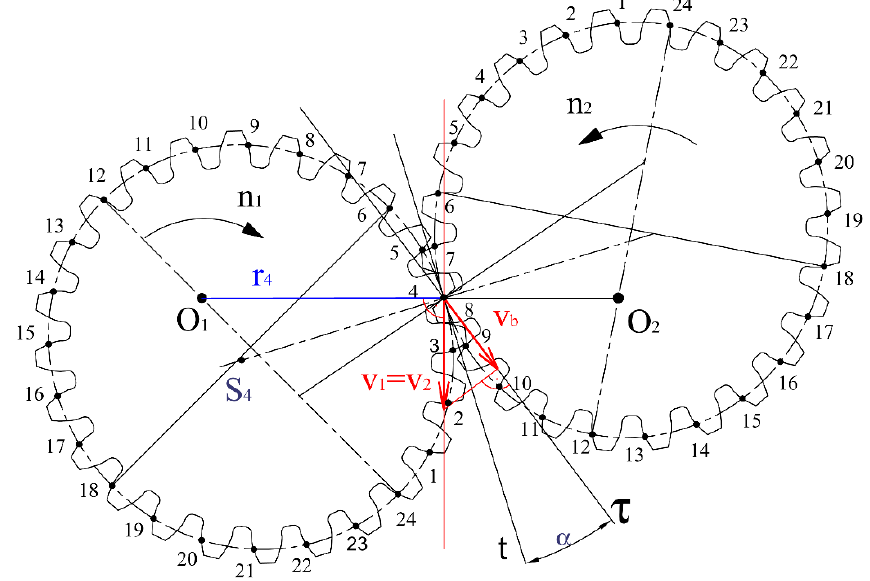
Figure 26. Velocity relations for the intermeshing teeth 4 and 8 in the central point of mesh. For the designed elliptical gear set, the magnitude of the circumferential velocity in the central point of mesh is different for each intermeshing pair of teeth. The direction of circumferential velocities of individual pairs of intermeshing teeth is identical, their position between the centers of rotation changes (Figure 27).